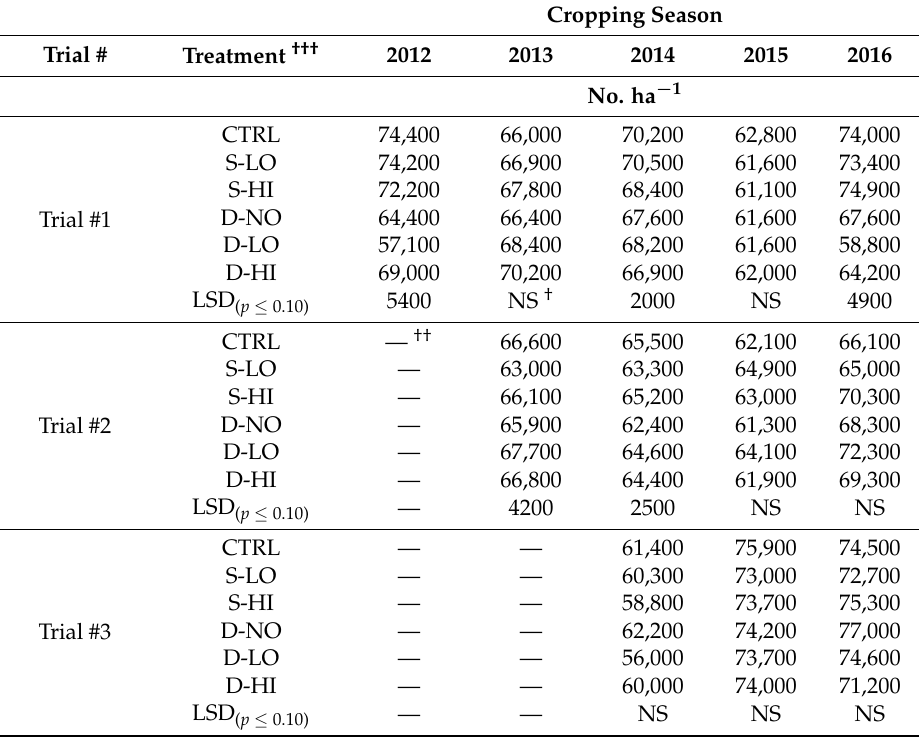
Table 3. Corn plant populations of lime treatments for all trials from 2012 to